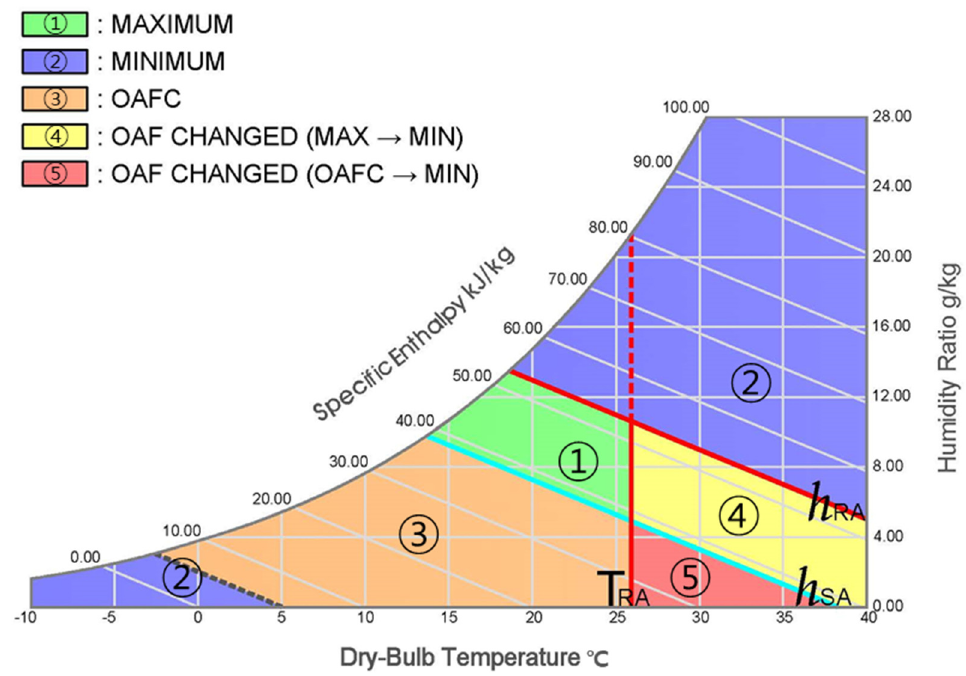
Figure 5. Di ff erential enthalpy and dry-bulb temperature control Figure 5. Differential enthalpy and dry-bulb temperature control method. Figure 5. Differential enthalpy and dry-bulb temperature control method.